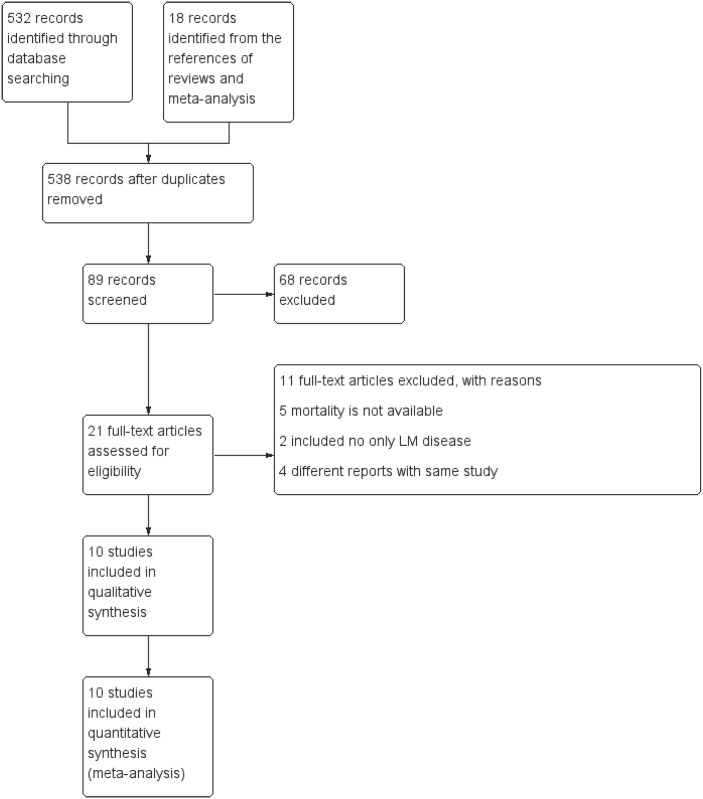
Flow chart of study selection.